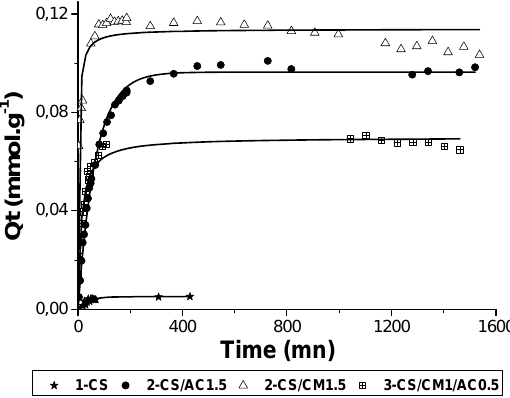
Figure 7. MTP adsorption kinetics of pure and hybrid hydrogel CS beads. The continuous lines represent the calculated data using the best-fitting model.